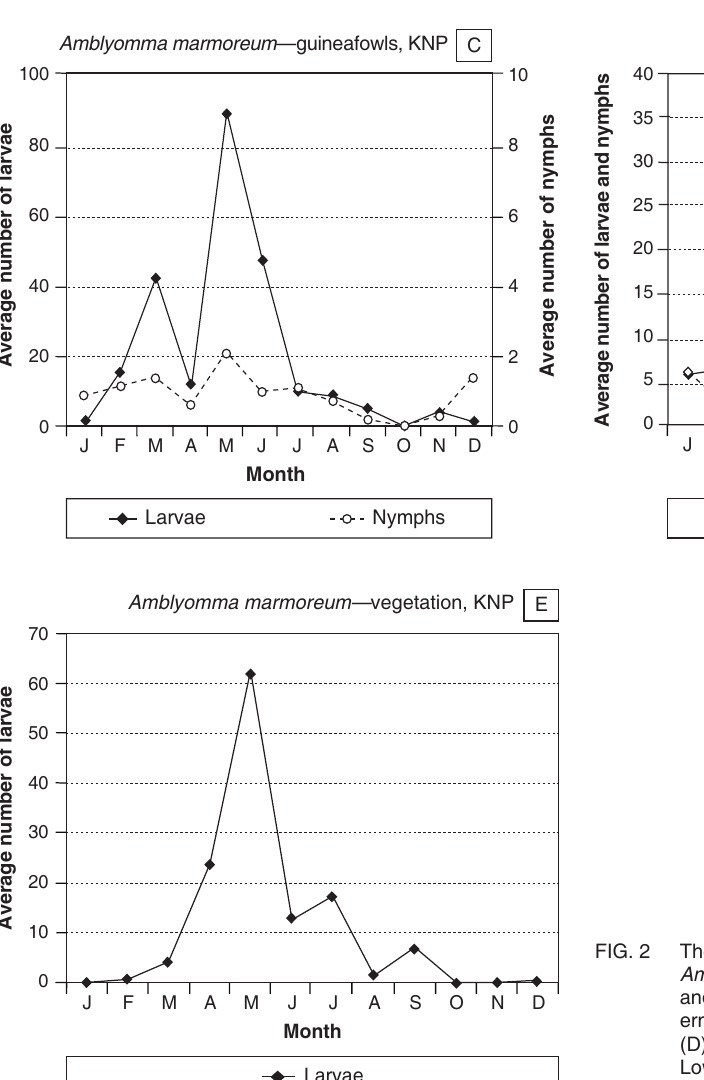
FIG. 2 The seasonal occurrence of the larvae and nymphs of Amblyomma marmoreum on (A) helmeted guinea fowls and (B) domestic cattle in Valley Bushveld in the East- ern Cape Province, and (C) helmeted guineafowls, and (D) scrub hares, and of larvae on (E) vegetation in the Lowveld of north-eastern Mpumalanga Province. KNP = Kruger National